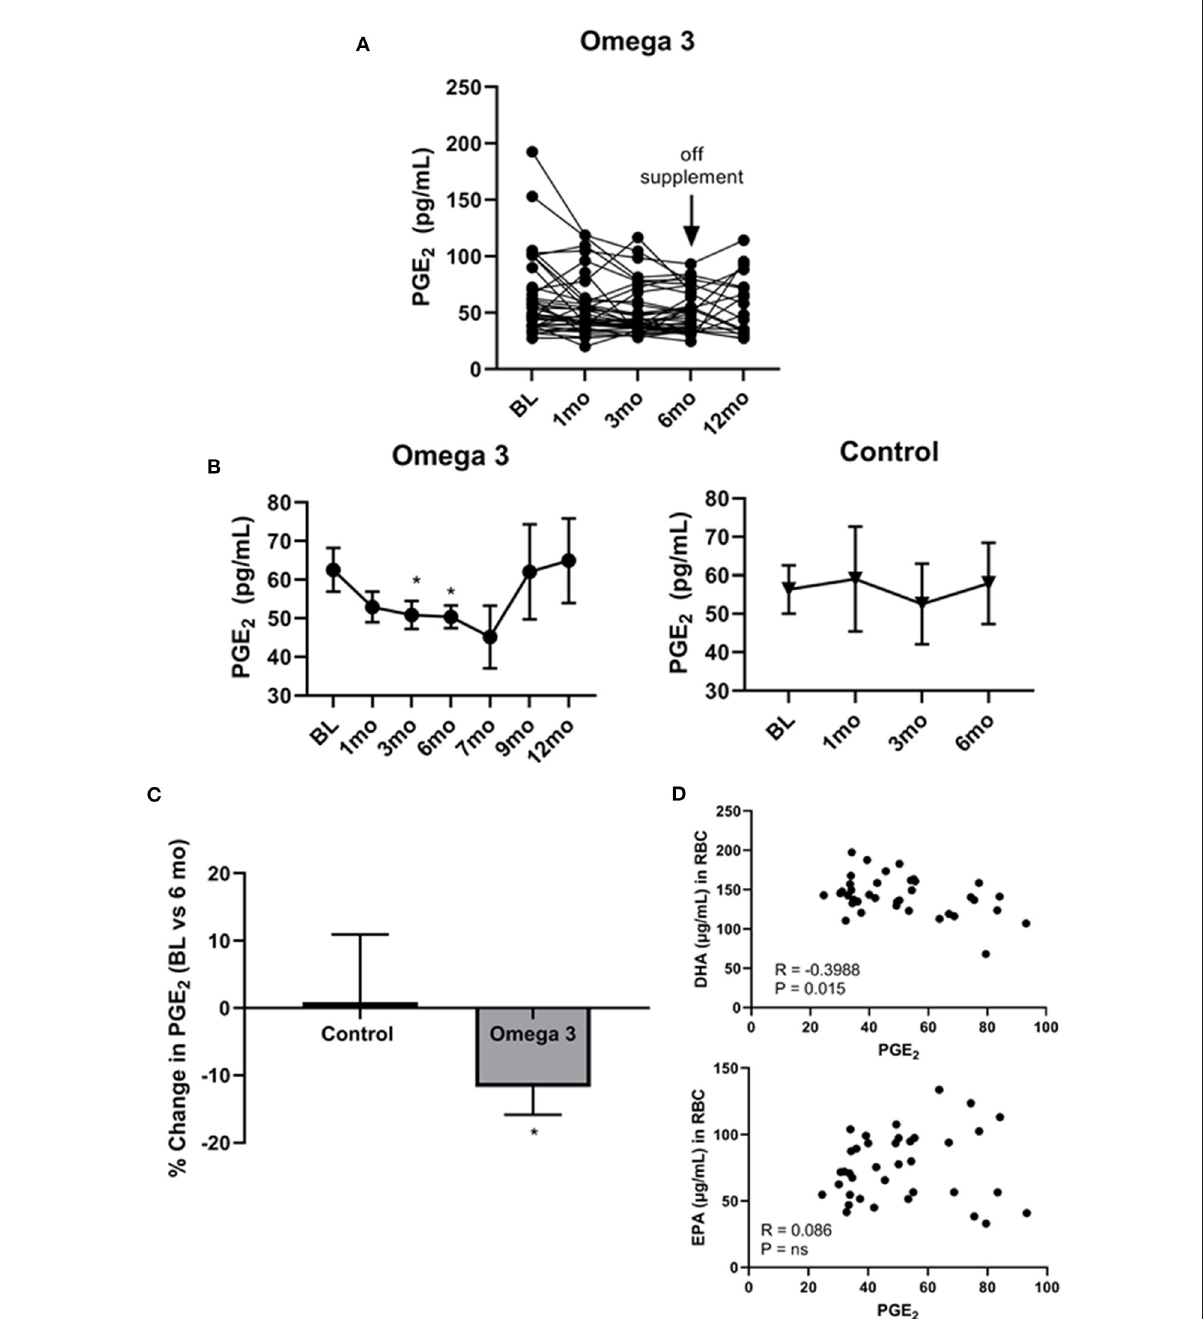
FIGURE5 Omega 3 supplements significantly lower PGE 2 levels. (A) Individual PGE 2 levels of the participants on omega 3 supplements for 6 months as determined by PGE 2 competitive ELISAs. (B) Average plasma PGE 2 levels over time from participants taking omega 3 supplements for 6 months (left panel) and from the control group (right panel) over 6 months. All average values shown are the mean ± SEM. (C) Percent change in PGE 2 levels after 6 months on omega 3 supplements, relative to baseline levels. (D) Correlation between EPA and DHA ( µ g/mL) levels in RBC membranes and PGE 2 levels of participants consuming omega 3 supplements for 6 months. *Denotes significant ( P < 0.05) difference when compared to baseline